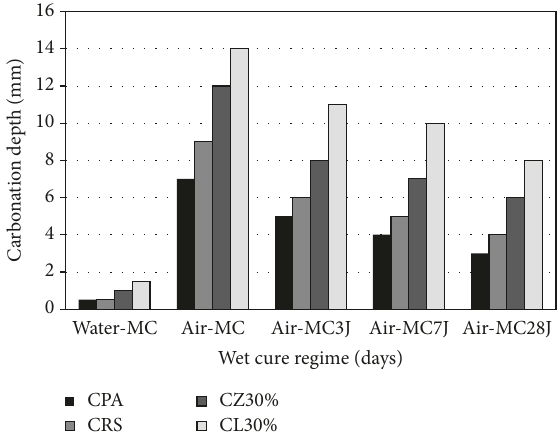
Figure3:Influenceofwetcuringregimeonthecarbonationattitude of cement at one